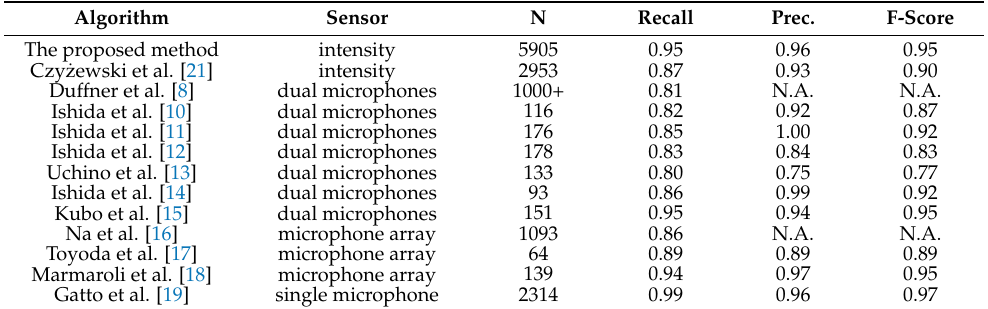
Table 3. A comparison of performance of vehicle detection algorithms based on acoustic sensors.